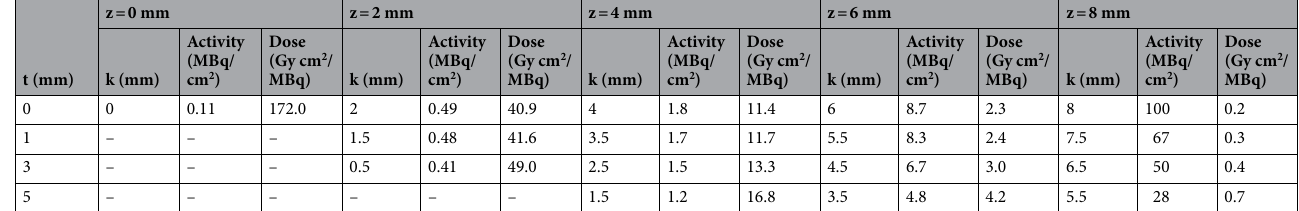
Table 1. Activity per unit area and dose per activity on unit area of the tumour bed in a water bulk material in the points facing the treated region, at different distances z from the central plane of the BAT-90 layer. Values of t in the range 0–5 mm are considered. k is the thickness of the tissue shell irradiated. Only values in the bulk material outside the BAT-90 layer (z > t/2) are reported.